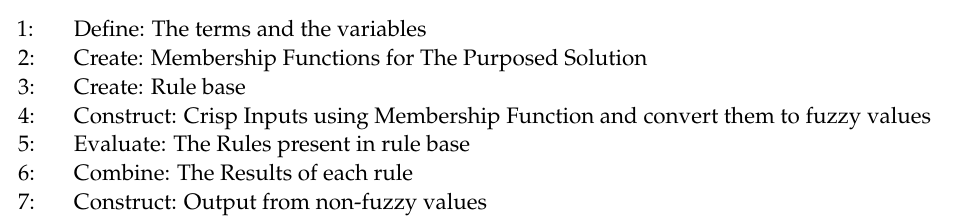
Algorithm 1. The Purposed Fuzzy Logic